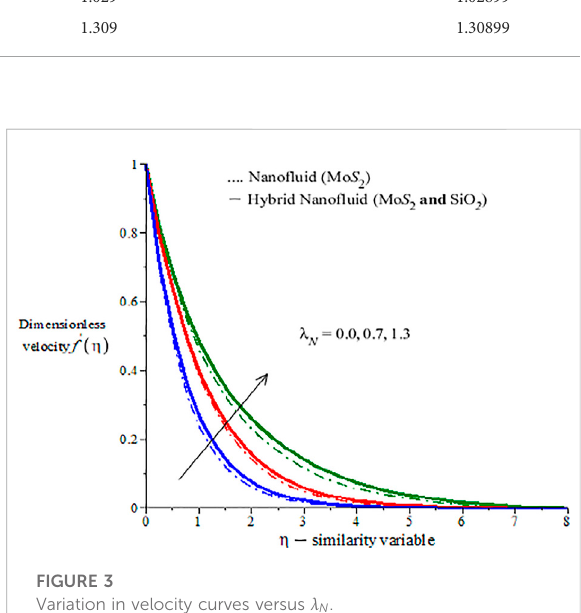
FIGURE 3 Variation in velocity curves versus λ N